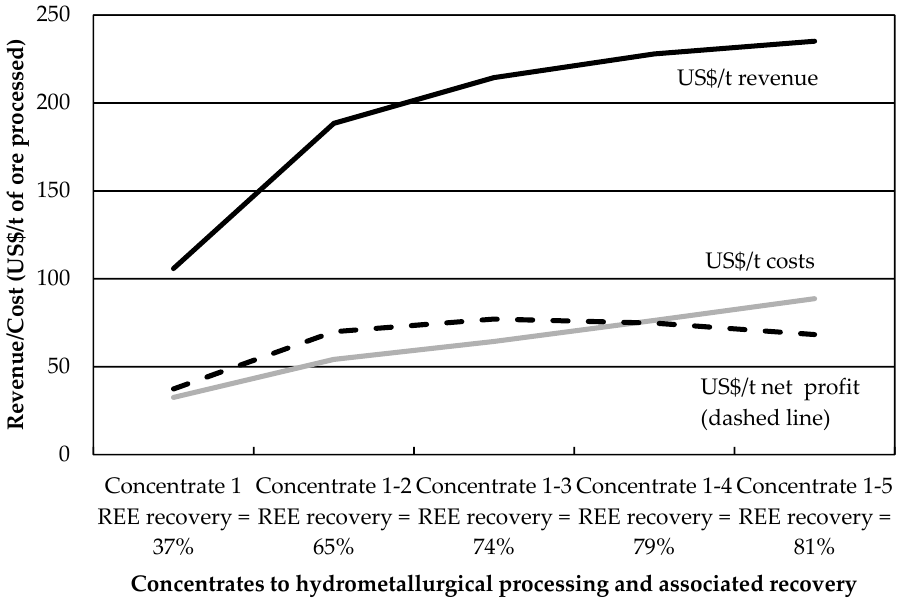
Figure 9. Calculated costs, revenues and profits (dashed) of hydrometallurgical processing as a function of REE recovery.